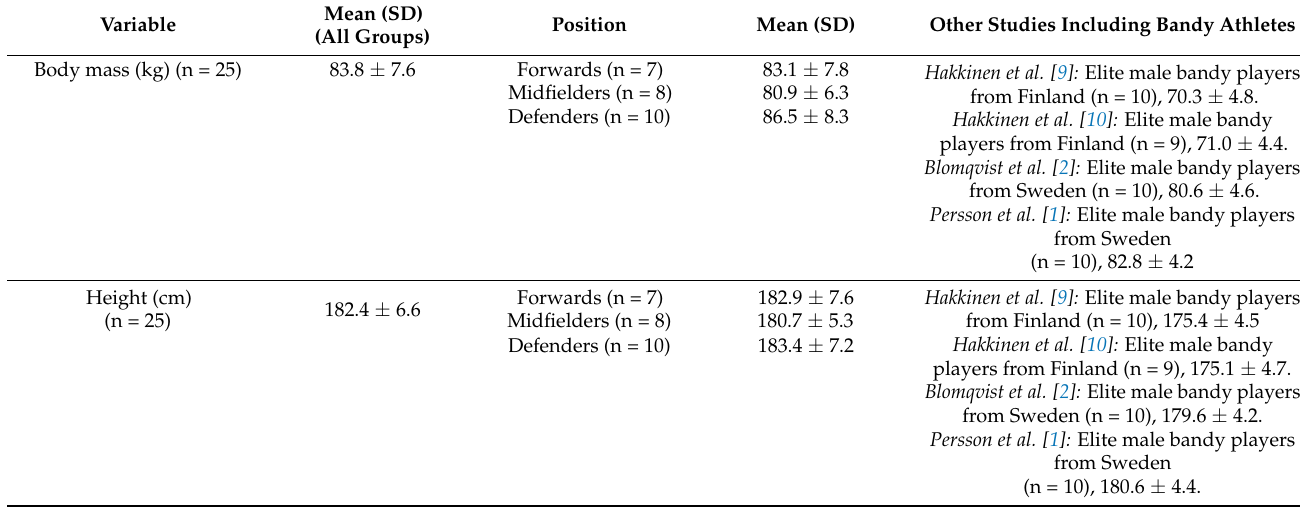
Table 1. Anthropometric characteristics of the